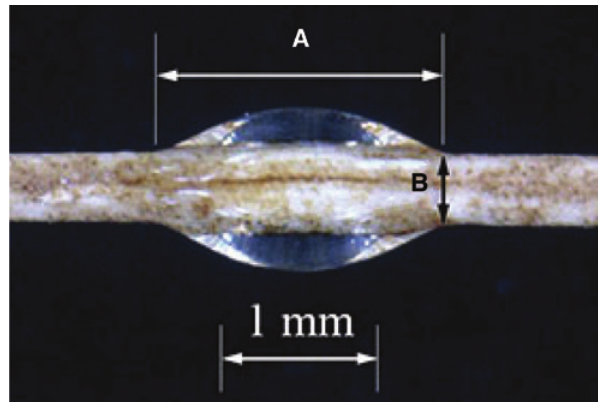
Figure 3: Enlarged image of epoxy microdroplet on DPF surface; (A) embedded length and (B) fiber diameter.